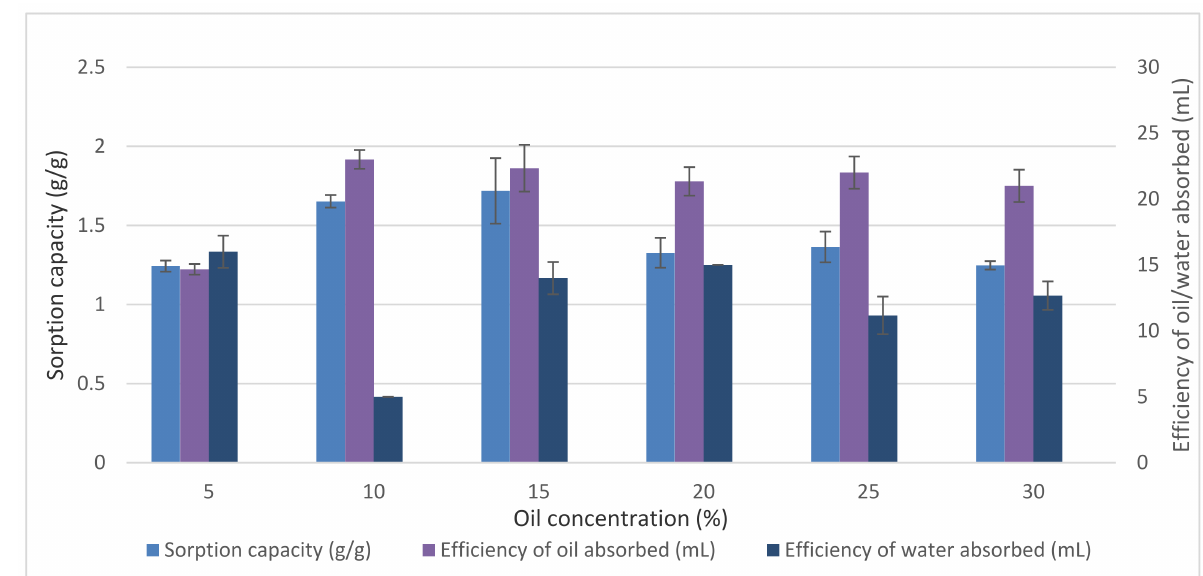
Figure 8. Effects of oil concentration on EFB treated fibre. Data obtained were the average efficiency of oil absorbed (%), the efficiency of water absorbed (%), and sorption capacity (g/g) on temperature. Vertical bars indicate SEM of three